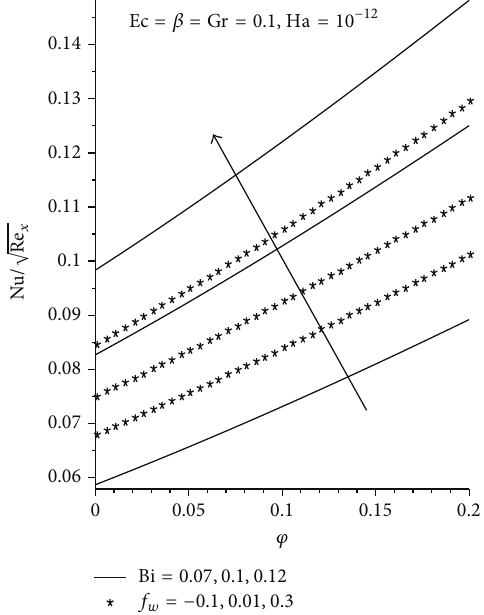
Figure 12: Effects of increasing 𝜑 , Bi, and Ha on local Nusselt number.